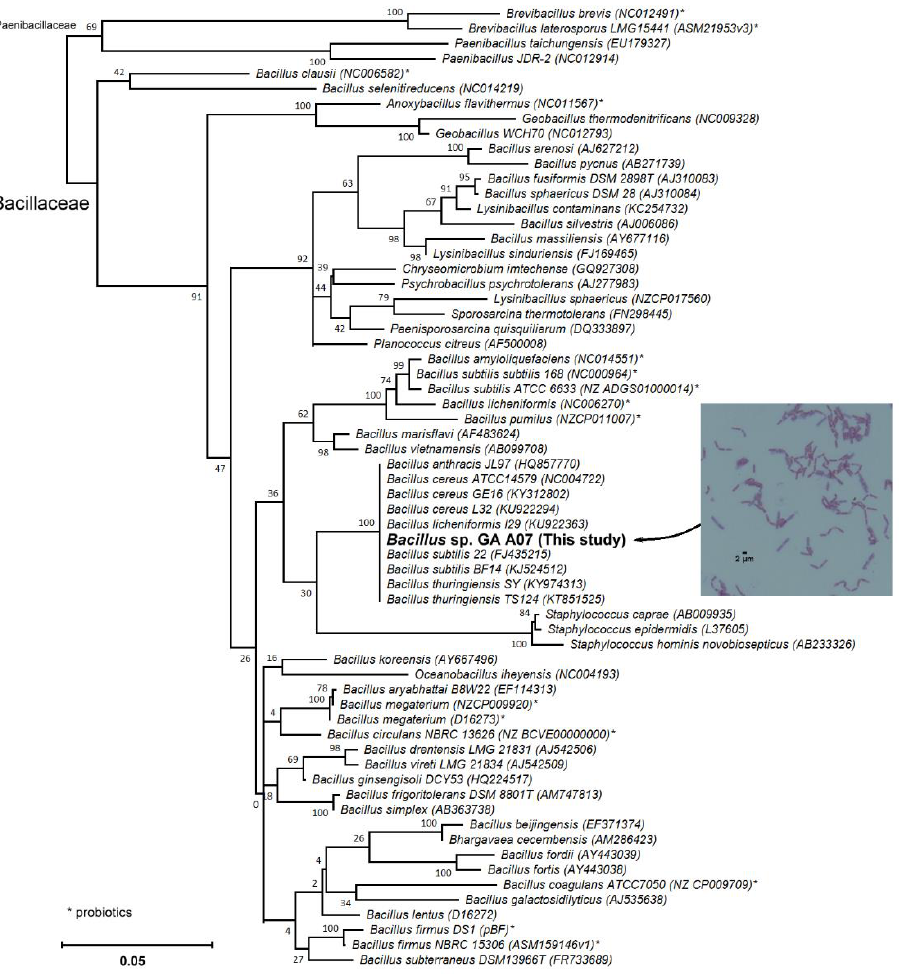
Figure 2. Molecular phylogenetic analysis of the strain GA A07 with the maximum likelihood (ML) method based on the general time reversible (GTR) model